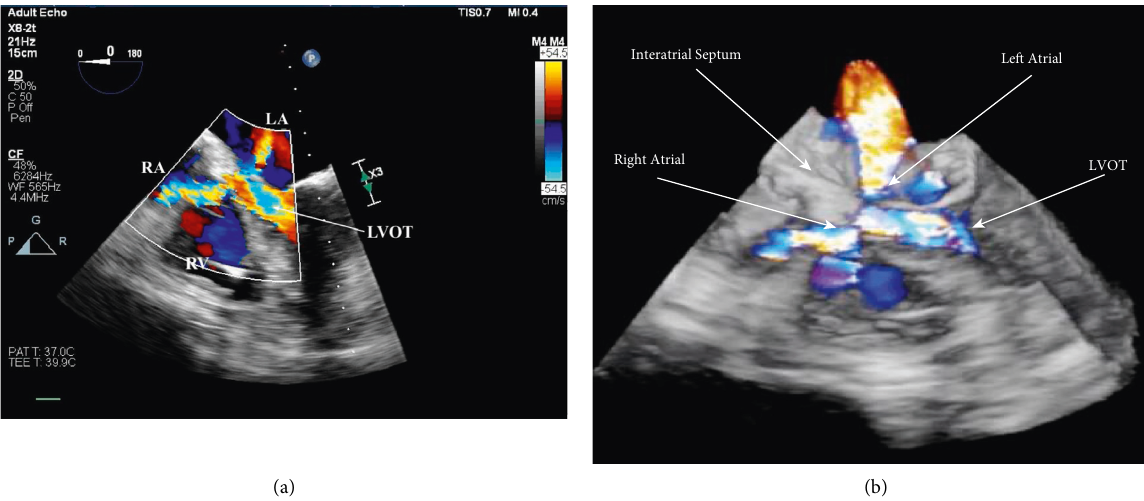
Figure 1: Postoperative day 2 TEE demonstrating two distinct regurgitant jets by color flow Doppler (CFD) with a common origin in the LVOTcommunicating with both the RA and LA. (a) 2D CFD of the mid-esophageal four-chamber view that has been cropped and (b) 3D CFD full-volume reconstruction (Philips X8-2t probe, Cambridge,